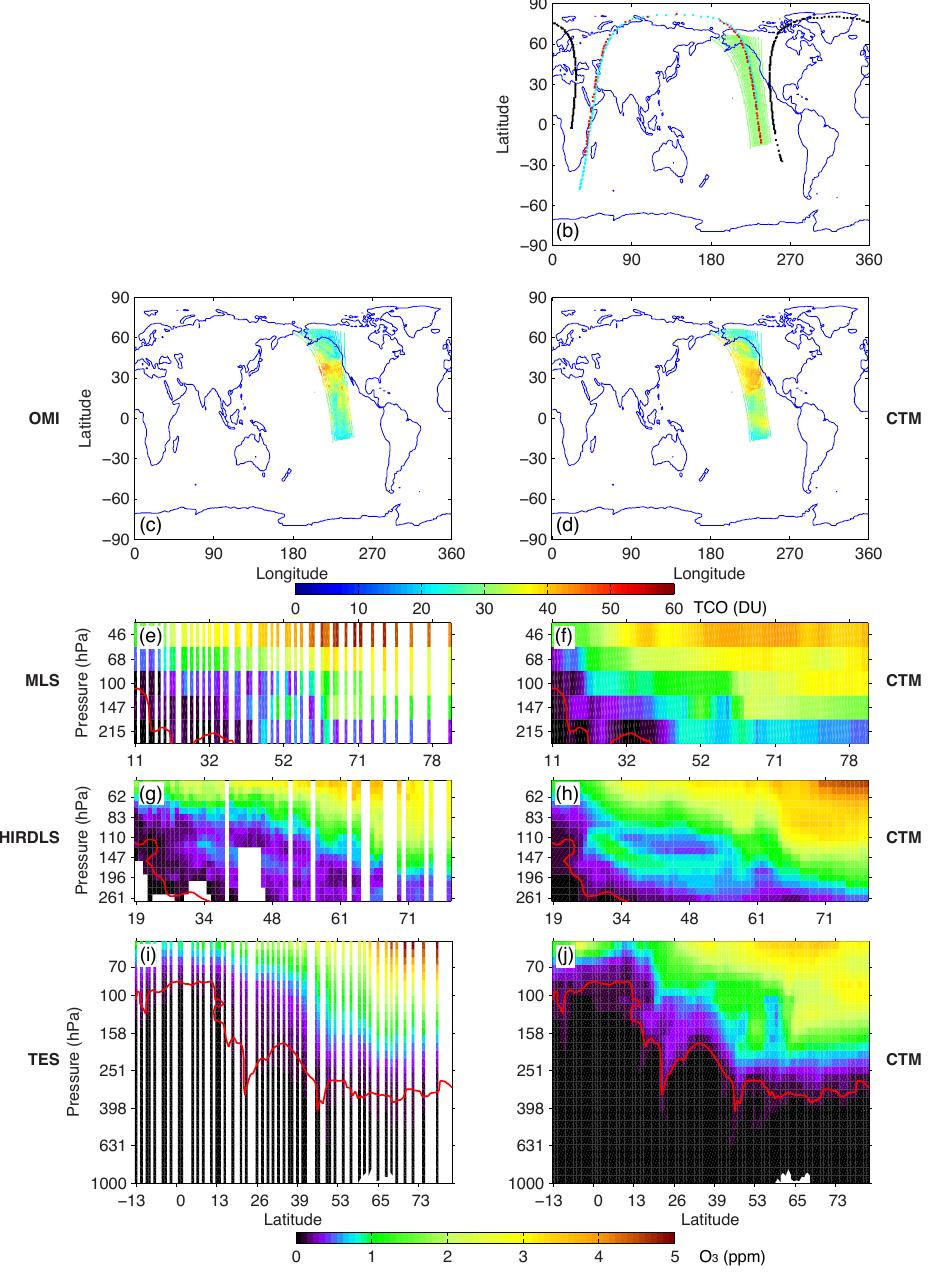
Fig. A7. Same as Fig. 3 for 26 January 2006 except that no sonde is available and the e90 tropopause is indicated by red solid lines in (e) – (j) . The Aura and CTM swaths are for 22:00–23:00UTC. (c) – (j) show the swaths in 181 ◦ E–270 ◦ E. (g) and (h) only show the HIRDLS swath at 19 ◦ N–74 ◦ N to mimic the Fig. 1 of Olsen et al.